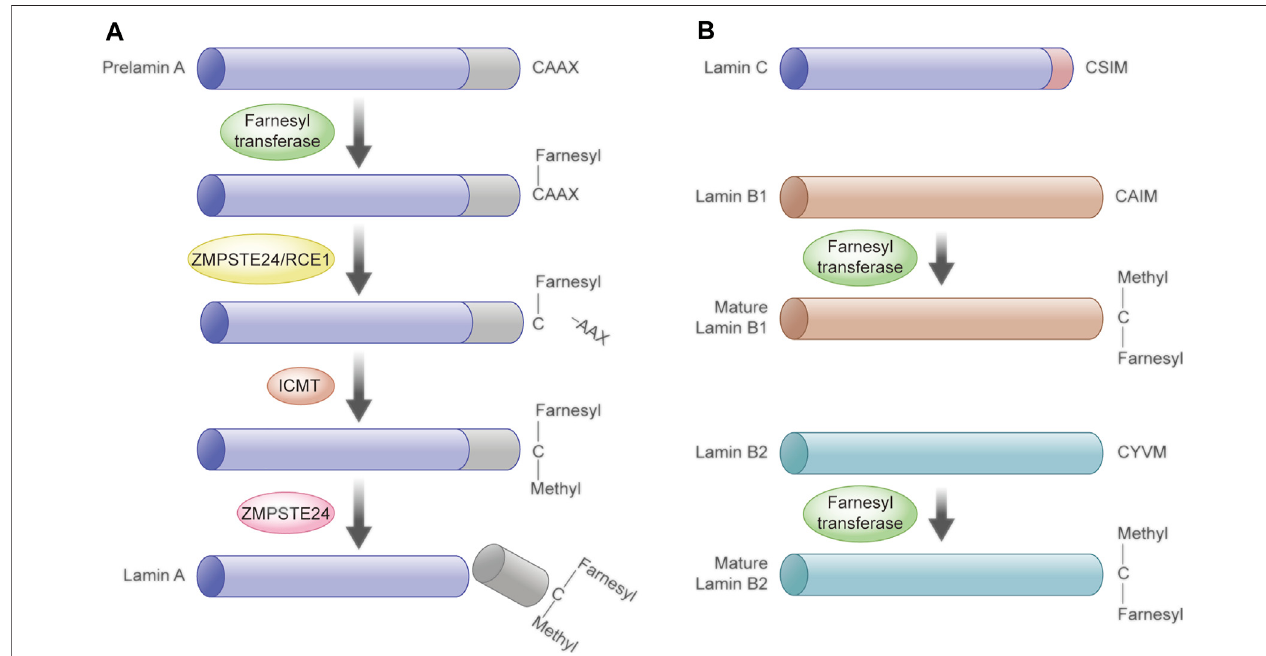
FIGURE 2 | Post-translational procession of prelamin A, B1, and B2. (A) Post-translational procession of prelamin A to lamin A. Prelamin A undergoes four post- translational chemical reactions before the mature lamin A is formed. Step I, the farnesyltransferase mediates farnesylation of the CAAX motif of prelamin A. Step II, the last tripeptide is clipped off by ZMPSTE24 or RCE1. Step III, ICMT methylates the exposed farnesylated cysteine residue. Step IV, removal of the last 15 amino acid residues by ZMPSTE24, including the C-terminal farnesylcysteine methyl ester. (B) Lamin C does not undergo these processing steps as it does not contain the CAAX motif. The mature lamins B1 and B2 remain permanently farnesylated at their C-termini.